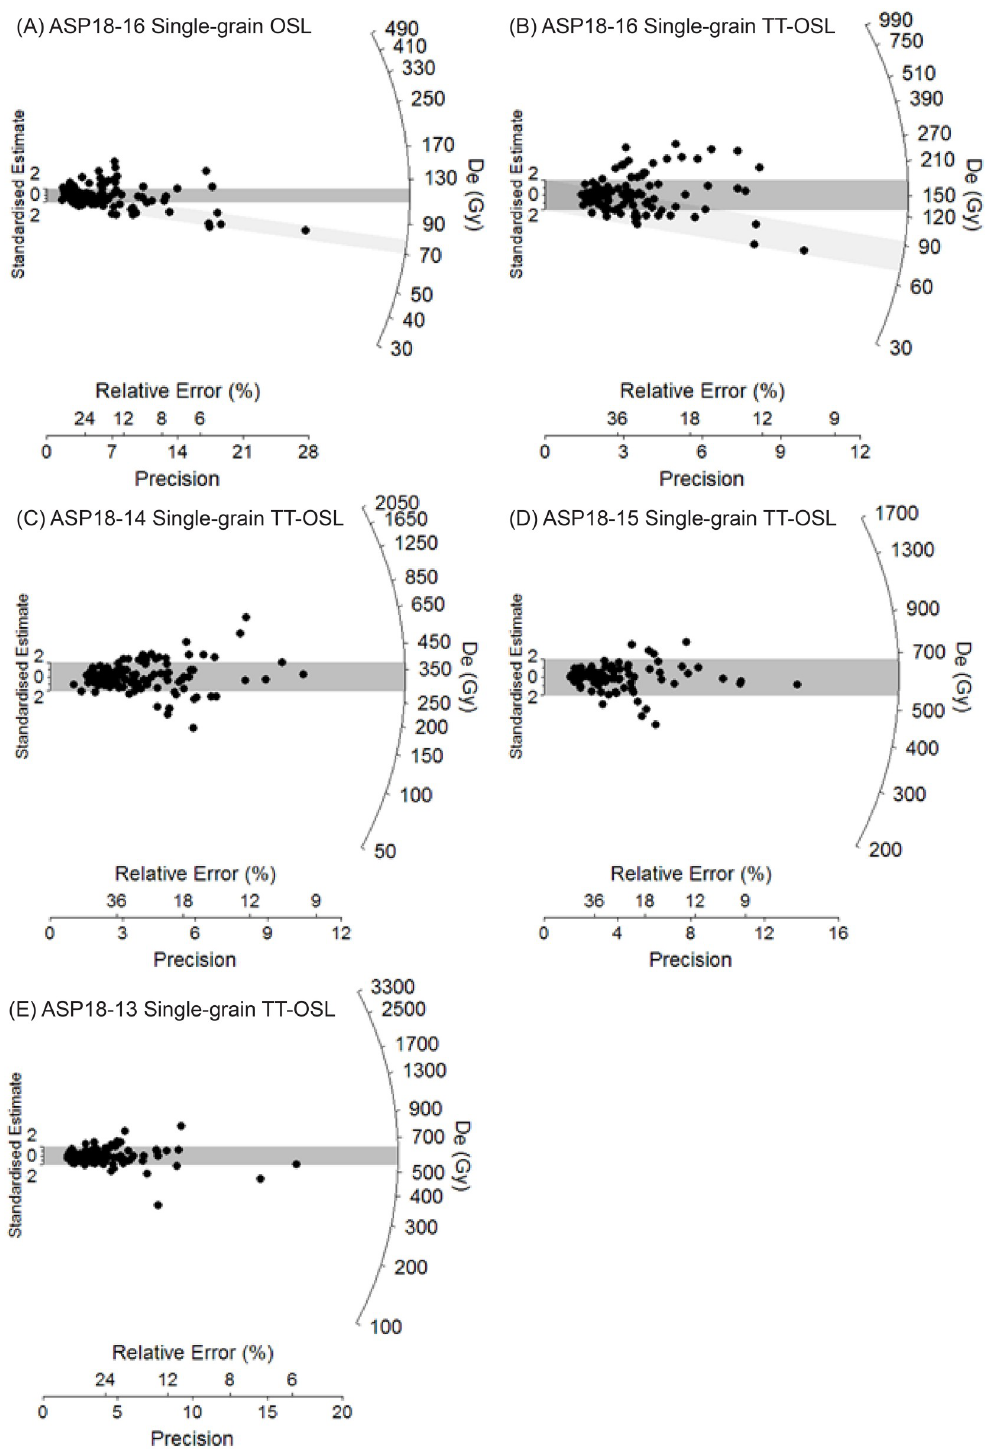
Fig 6. Single-grain OSL and TT-OSL D e distributions for the Area 1 luminescence dating samples, shown as radial plots. The shaded bands are centred on the D e values used for the age calculations, which were derived using either the 3-parameter minimum age model (light grey band sample ASP18-16) or the central age model (dark grey bands samples ASP18-14, ASP18-15, ASP18-13, ASP18-16) of Galbraith et al. [102].